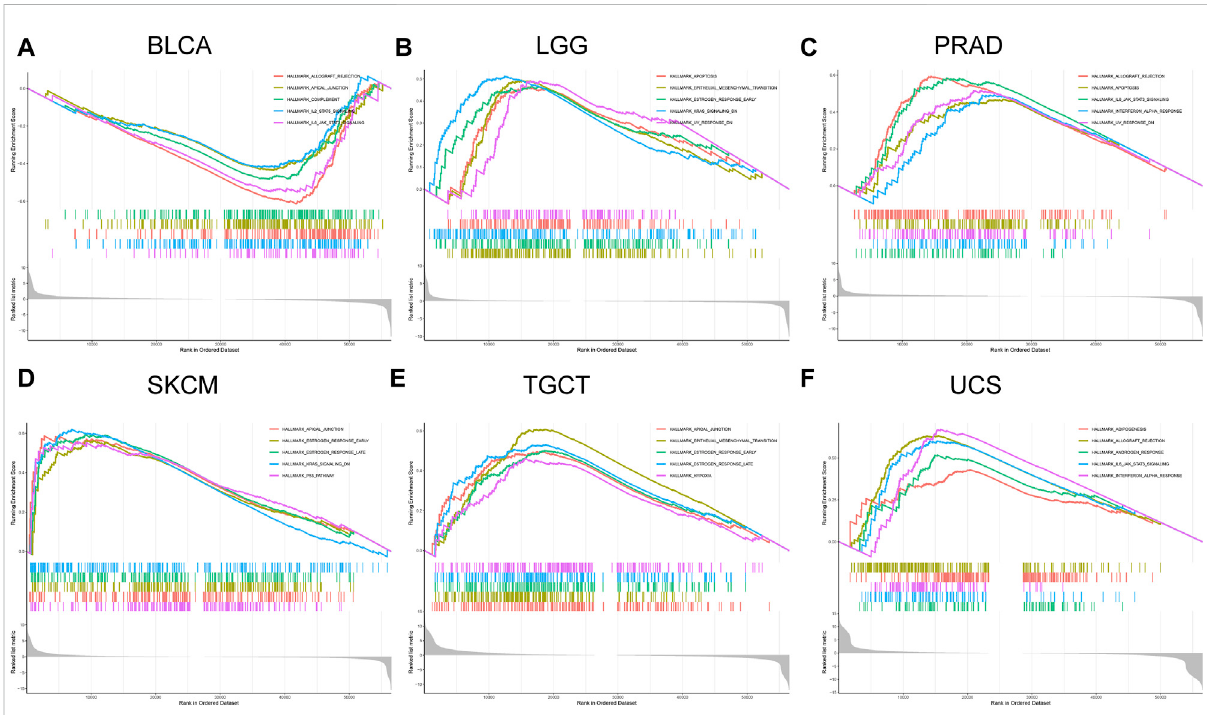
FIGURE 7 Association of forkhead box Q1 (FOXQ1) expression with cancer-related pathways in different cancers. Bladder urothelial carcinoma (A) , brain lower-gradeglioma (B) ,prostateadenocarcinoma (C) ,skincutaneousmelanoma (D) ,testiculargermcelltumors (E) ,anduterinecarcinosarcoma (F) .